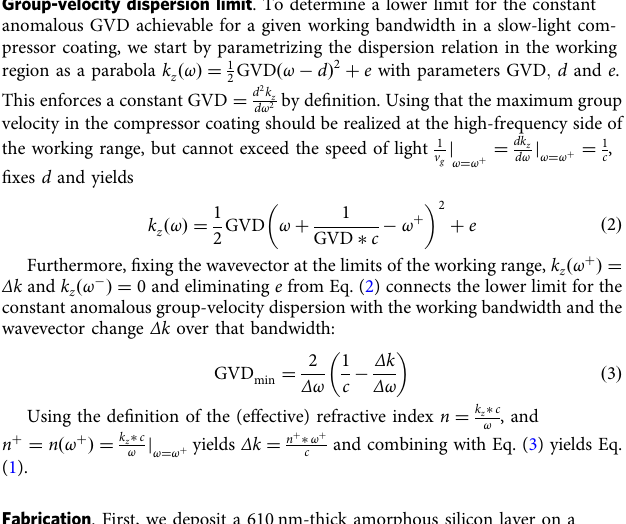
We measured spectrograms for: (i) the input laser pulses, (ii) the laser pulses affected by the fused silica substrate, and (iii) the laser pulses after traversing the compressor and substrate. Experimental spectrograms are displayed in Fig. 4a, b, whereas the full data set, retrieved spectrograms, and retrieval process 37,38 are detailed in the methods and Supplementary Fig. 5. Both, visual comparison of the reconstructed spectrograms (see Supplementary Fig. 5) and the trace-area normalized FROG error G ’ < 0.05 39,40 of the reconstructed spectrograms indicate good agreement. In the time-domain (Fig. 4c, d), the compressor reduces the pulses ’ full-width-at-half-maximum duration by a quarter from NATURE COMMUNICATIONS| (2021) 12:6518